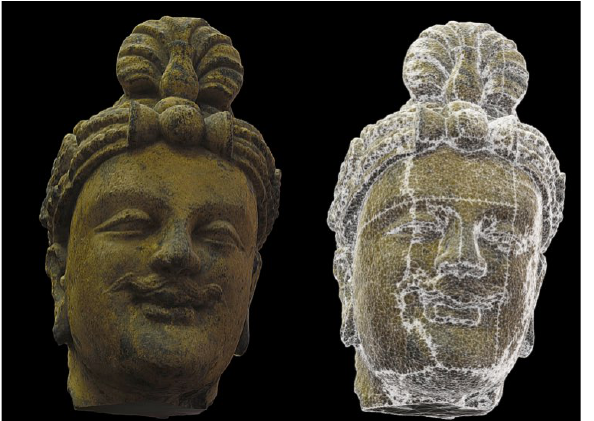
Figure 7: Gilt grey schist Bodhisattva from the ancient region of Gandhara circa 2nd - 3rd Century, H 15.5 cm. Cyber Archive by photogrammetry.